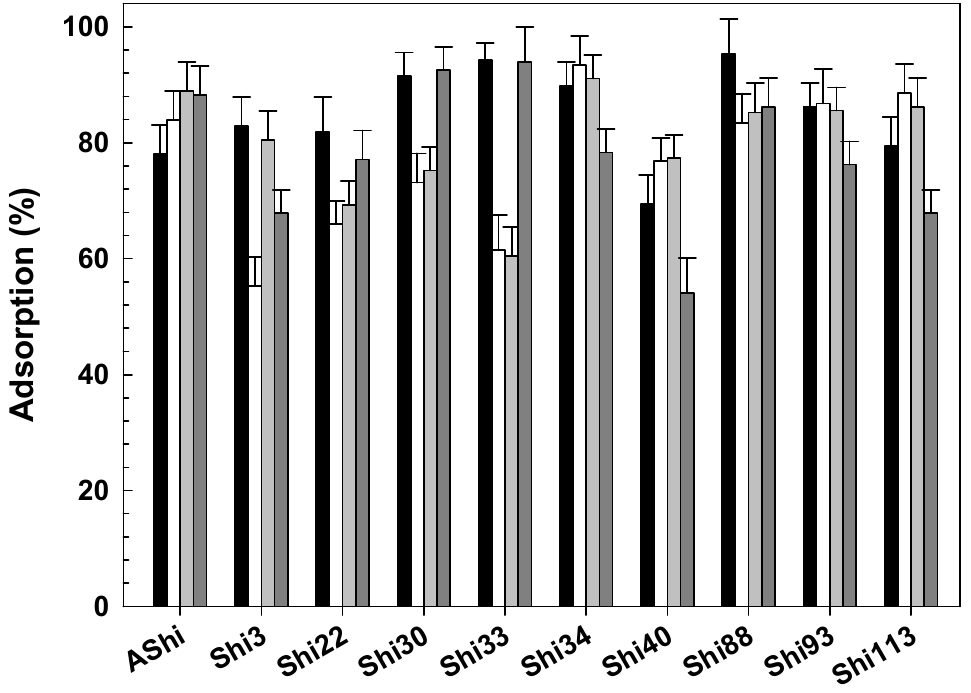
◦ Figure 2. Phage adsorption in TSB at 4 °C (  ), 25 °C (  ; control), 37 °C (  ) and 50 °C (  ) on Figure 2. Phage adsorption in TSB at 4 °C (  ), 25 °C (  ; control), 37 °C (  ) and 50 °C (  ) on Figure 2. Phage adsorption in TSB at 4 °C (  ), 25 °C (  ; control), 37 °C (  ) and 50 °C (  ) on Figure 2. Phage adsorption in TSB at 4 C ( Figure 2. Phage adsorption in TSB at 4 °C (  ), 25 °C (  ; control), 37 °C (  ) and 50 °C (  ) on ATCC12022 viable cells. Values are the mean ± standard deviation (error bars) of three ATCC12022 viable cells. Values are the mean ± standard deviation (error bars) of three ATCC12022 viable cells. Values are the mean ± standard deviation (error bars) of three ATCC12022 viable cells. Values are the mean ± standard deviation (error bars) of three determina- Figure 2. Phage adsorption in TSB at 4 °C (  ), 25 °C (  ; control), 37 °C (  ) and 50 °C (  ) on determinations. determinations. tions. ATCC12022 viable cells. Values are the mean ± standard deviation (error bars) of three determina ‐ tions.